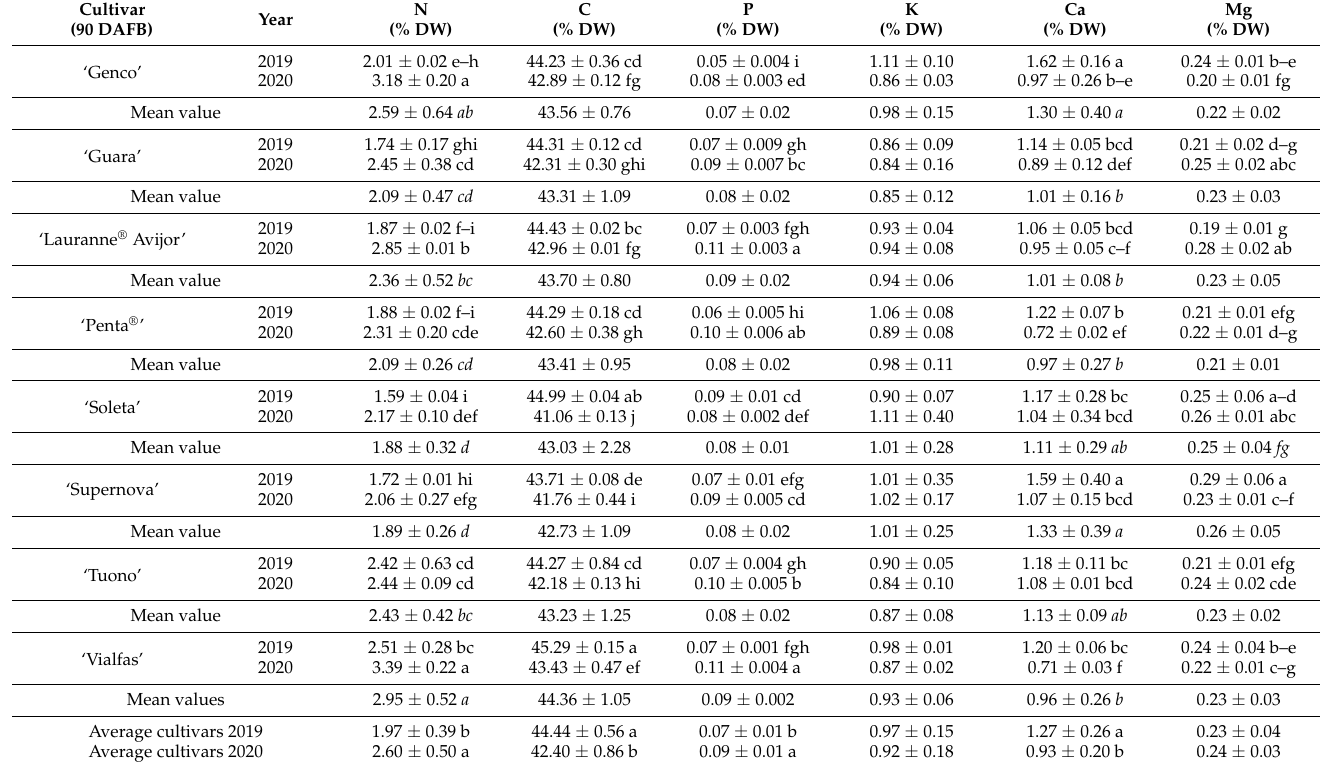
Table 3. Macronutrients content (% DW) in almond leaves collected at 90 DAFB over the years 2019–2020. (N = nitrogen, C = carbon, P = phosphorus, K = potassium, Ca = calcium, Mg = magnesium). Data are presented as mean ± standard deviation. Different lowercase letters on the columns indicate significant differences between means (Fisher’s test p < 0.05). Lowercase letters in italics describe the differences expressed as two-year mean values of the